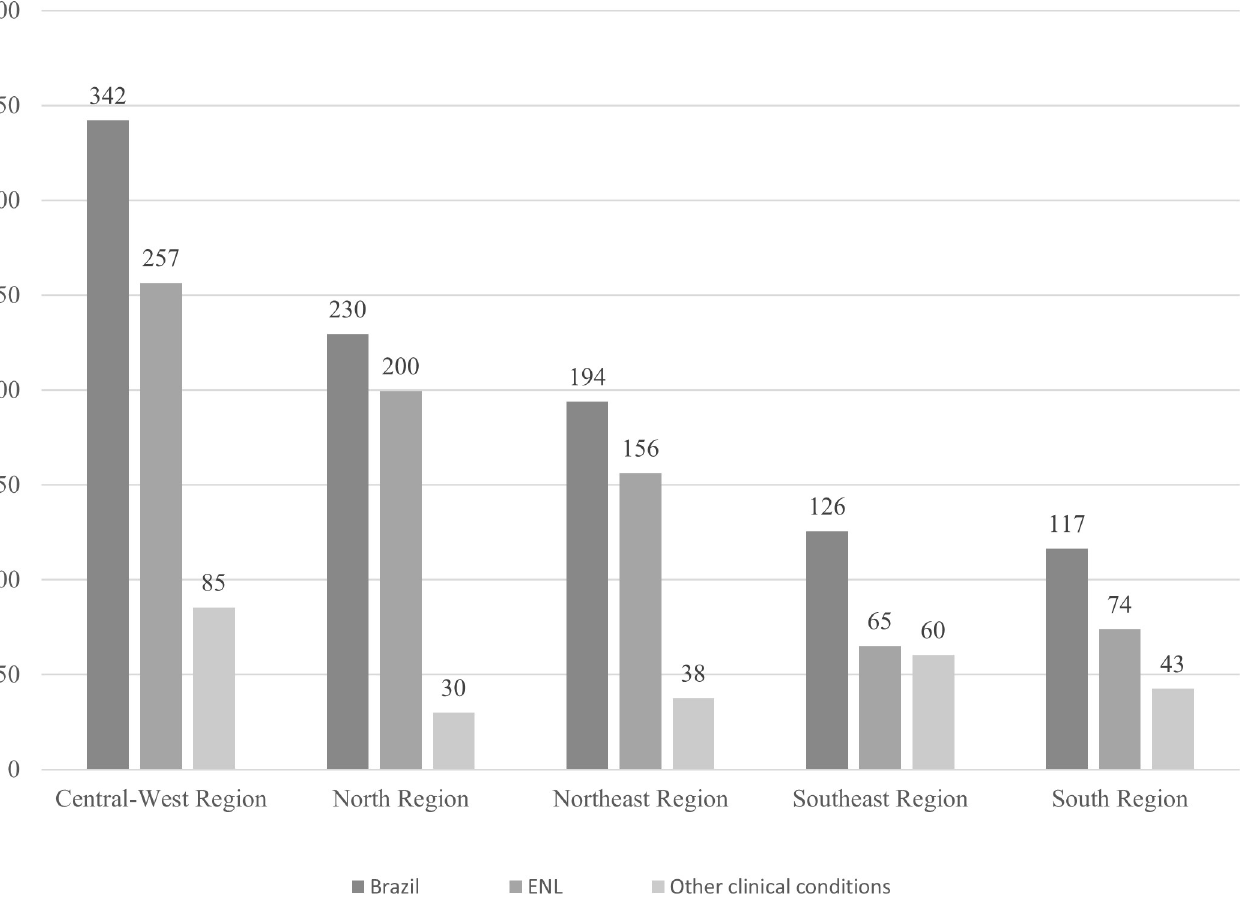
Fig 4. Average rate of distribution of 100 mg thalidomide tablet/10 thousand inhabitants among the Brazilian regions, from 2011 to 2018. Average number of 100 mg thalidomide tablets in the state between 2011 and 2018/average total population in the state between 2011 and 2018 per 10,000 inhabitants. Other clinical conditions (lupus, multiple myeloma, aphthous ulcers in patients with HIV-AIDS, graft-versus-host disease, and myelodysplastic syndrome) [58,63].ENL, erythema nodosum leprosum.